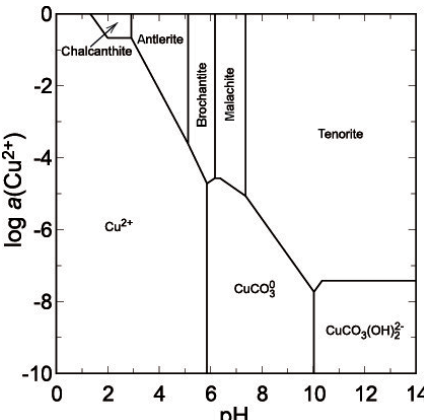
Figure 9. p ε -pH diagram of the system CuO − SO 3 − CO 2 − H 2 O for T = 298 . 15 K, log f ( CO 2 , g ) = − 2 and log a( S(VI) ) = − 2.